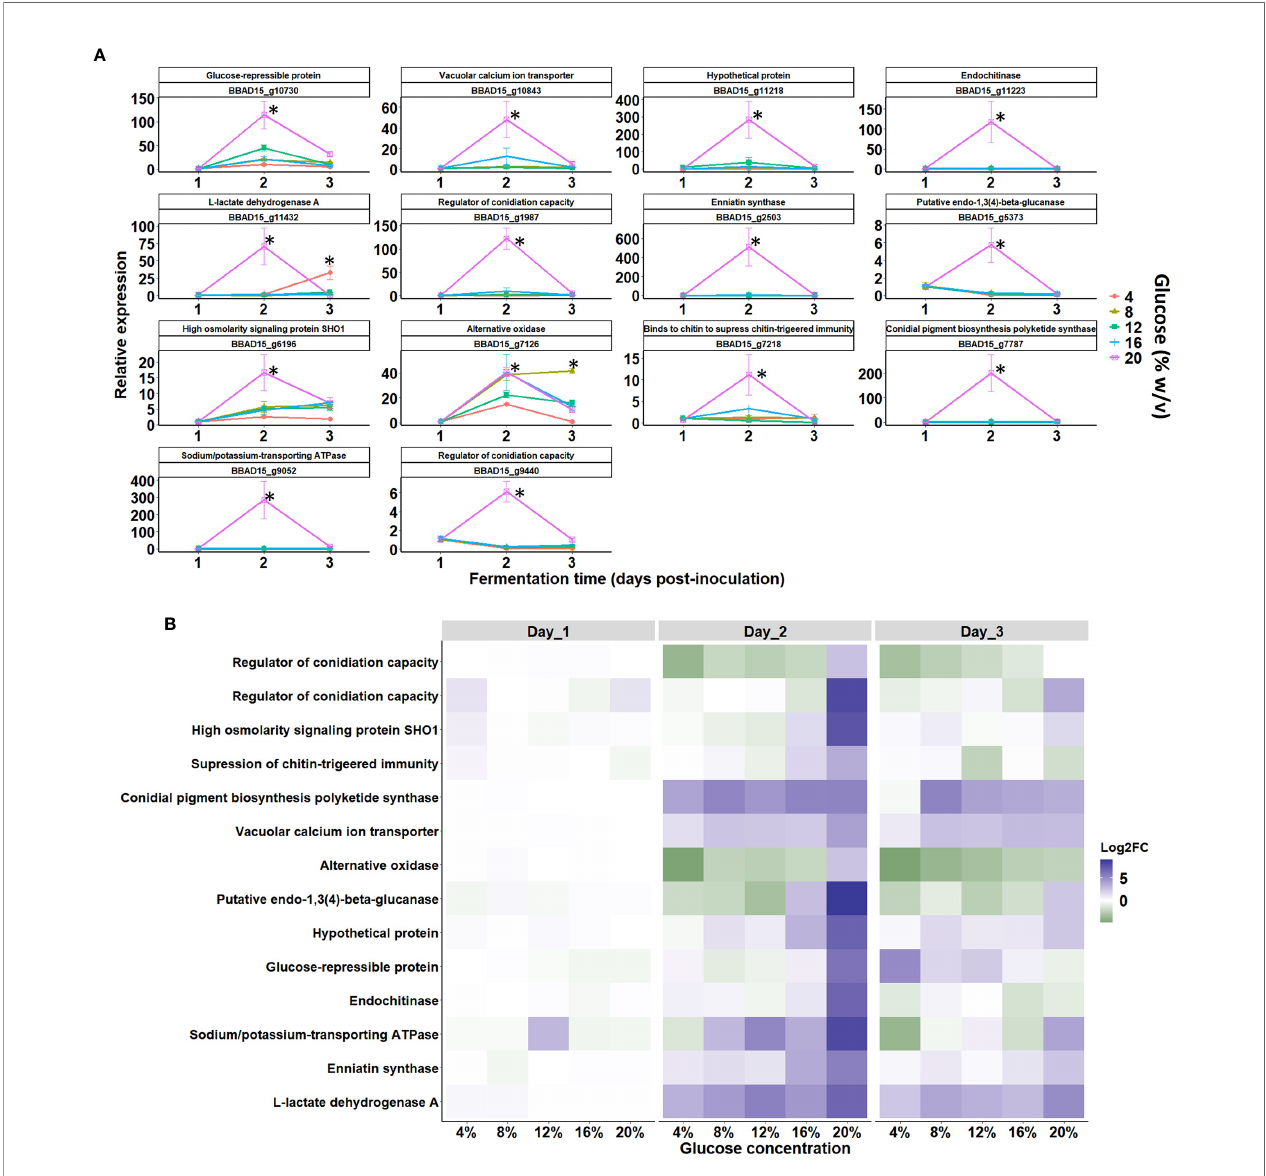
FIGURE 9 | Gene expression of key blastospore-related genes via qPCR during growth stages of B. bassiana in response to an increased glucose gradient. (A) Temporal elicitation of selected B. bassiana genes (expressed in fold change values normalized by the reference actin gene via DD Ct method) during the blastospore growth stages: early (day 1), middle (day 2), and late (day 3) responses under liquid fermentation (mean ± standard error). Signi fi cant differences between glucose concentrations within each growth phase are indicated by asterisks ( p < 0.05*) according to ANOVA. (B) Heatmap shows gene expression patterns at 1, 2, and 3 days post-inoculation and mean log 2 fold change values from three biological replicates and two technical replicates. The log2-FC values and the color scale are shown at the right of the heat map, where blue indicates upregulation, while green indicates